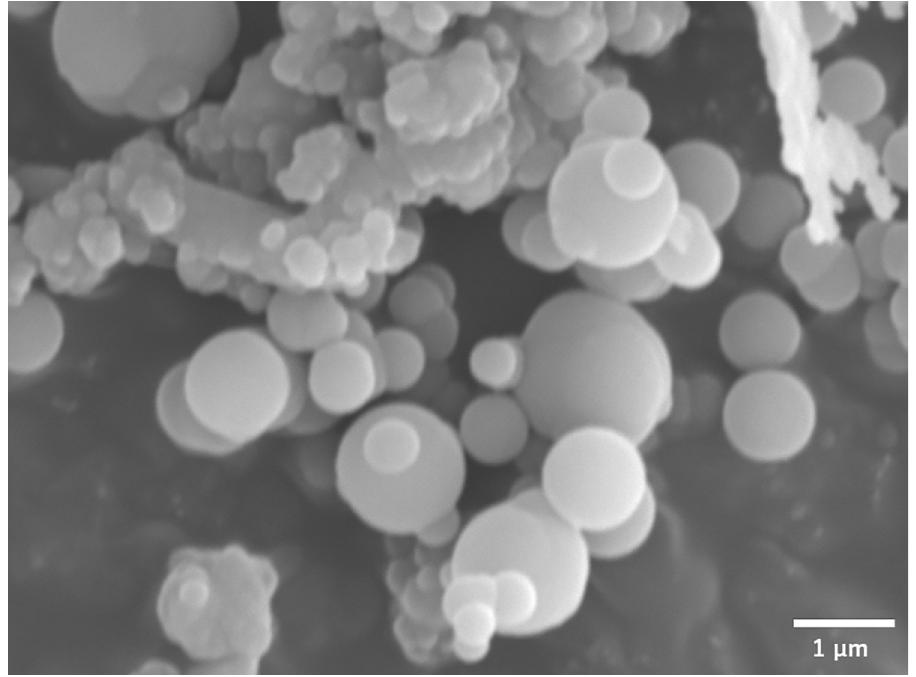
Fig 5. Scanning electron micrograph of insoluble